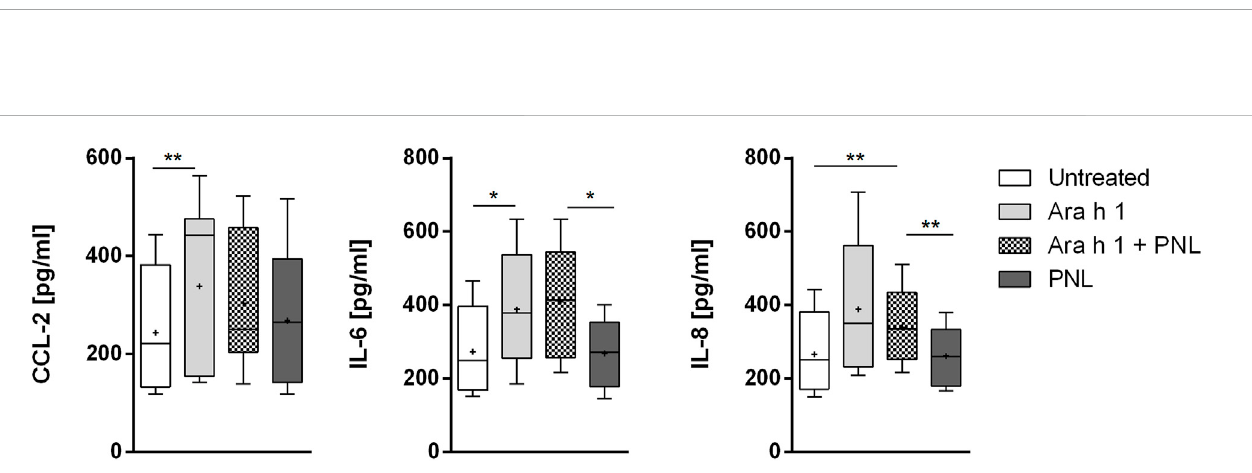
peanut-allergicindividuals.Dataofthreeindependentexperimentsarepresentedasmean±SD. (B) DetectionofArah2inthebasolateralmediumbyWB16 h after apical addition of Ara h 2 ± PNL. Lane 1: puri fi ed Ara h 2 (0.5 µg); loading control; Lane 2: Ara h 2; Lane 3: Ara h 2 + PNL; Lane 4: basolateral cell culturemediumofuntreatedcells. (C) Confocalimmuno fl uorescencemicroscopyimagesof16HBE14o-cellmonolayers.Allergens(green)wereinternalized for 1 h at 37 ° C. In the negative control, no allergen was present. The late endosome/lysosome marker LAMP2 is in red and nuclei in blue. Scale bar: 10 µm.